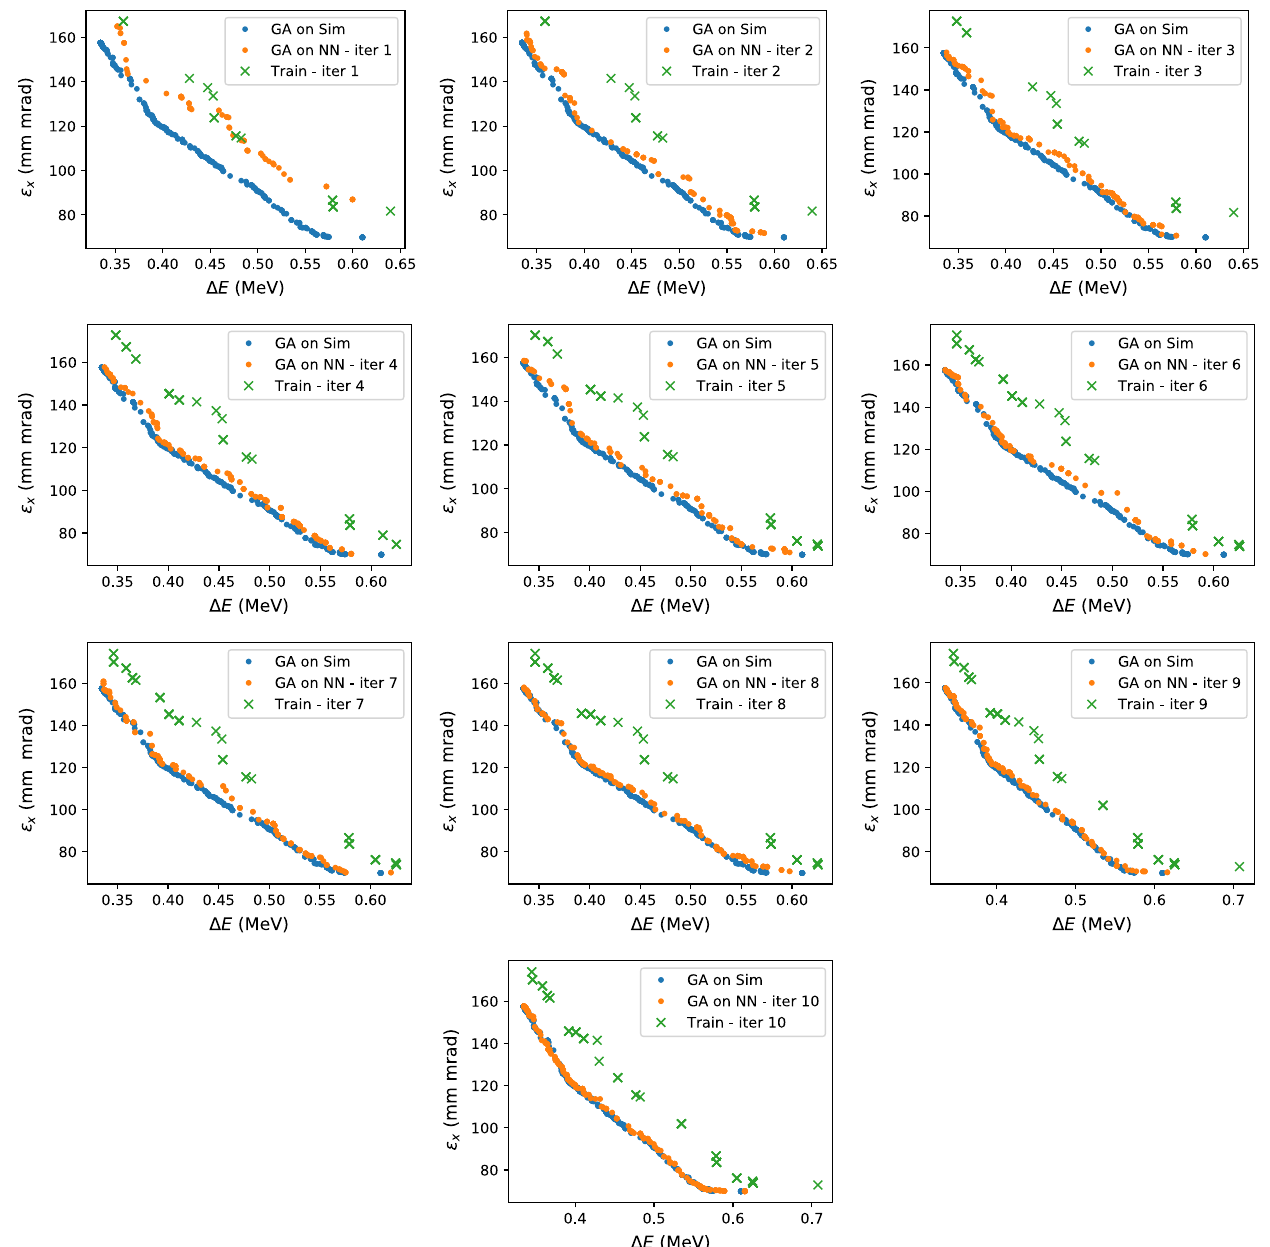
FIG. 10. Iterative retraining: Example of convergence of the estimated front for Δ E vs ε during iterative retraining. Here we show ten x iterations from one of the trials and display the estimated Pareto front projections from the physics simulation, from the NN model on each iteration of the retraining process, and from the training data used in that iteration. Substantially fewer points (e.g., 200 in this run) are needed to obtain an estimated front that matches the one obtained with the physics simulation, as compared with using a single random sample for training. Note that this example is one of the slower-to-converge runs, which we deliberately chose as a conservative demonstration of the method (i.e., other runs had a fewer number of required points, but that relies on lucky placement of the initial random sample